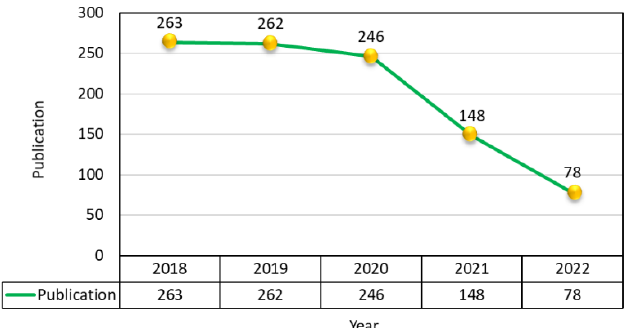
Fig. 5. Progress of Publication of Biomaterial Adsorption 2018 to 2022